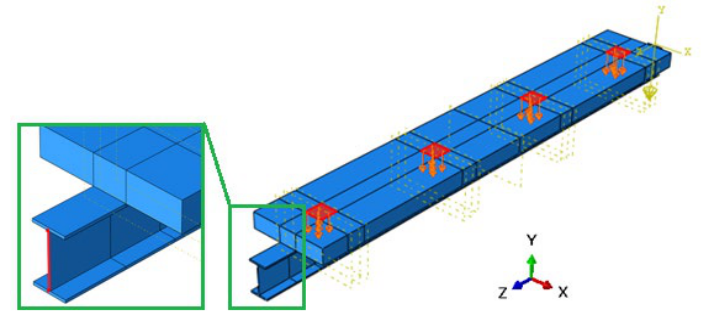
Figure 8. Load applied regions and Y axis restrained